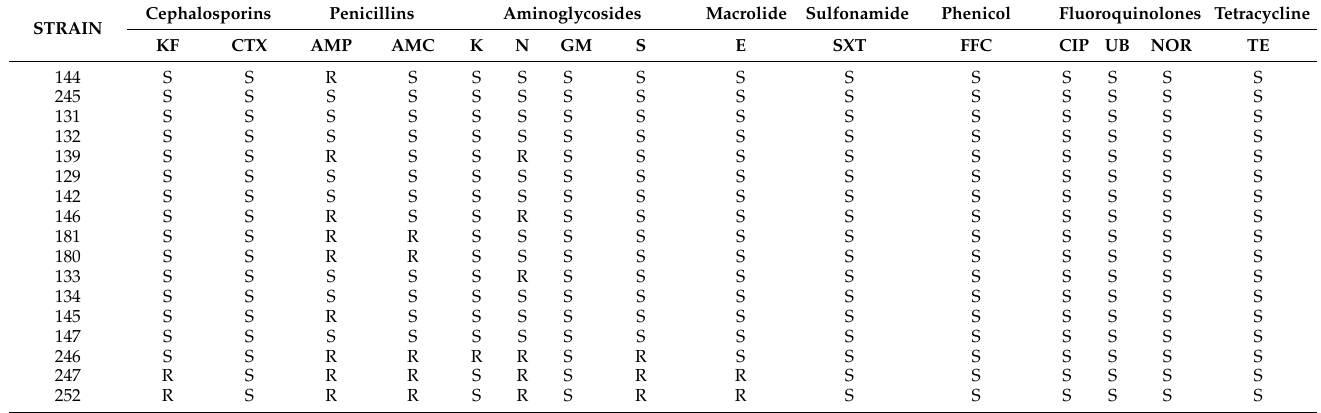
Table 3. List of the strains and the antibiotics used for the antibiograms (KF: cephalothin, CTX: cefotaxime, AMP: ampicillin, AMC: amoxicillin/clavulonate, K: kanamycin, N: neomycin, GM: gentamycin, S: streptomycin, E: erythromycin, SXT: trimethoprim sulfamethoxazole, FFC: florfenicol, CIP: ciprofloxacin, UB: flumequine, NOR: norfloxacin, TE: tetracycline). The results are depicted by R: resistant and S: